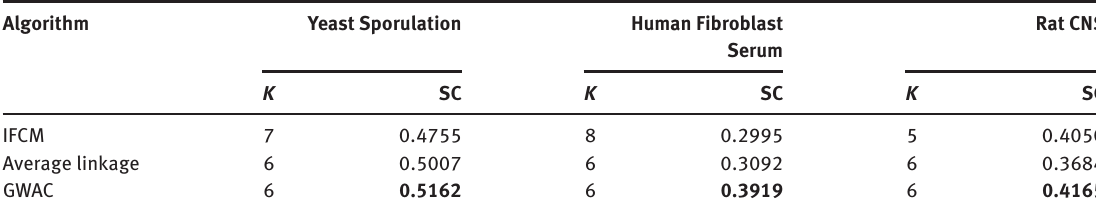
Table 12: SC Values for Real-Life Gene Expression Data